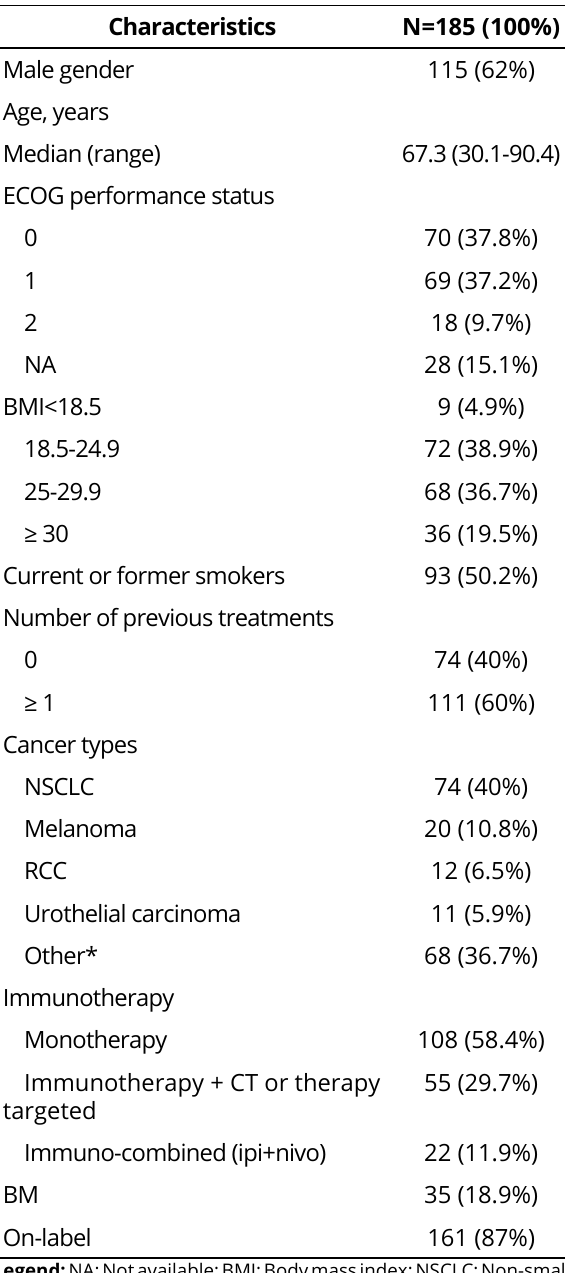
Table 1. Patients and treatment characteristics.